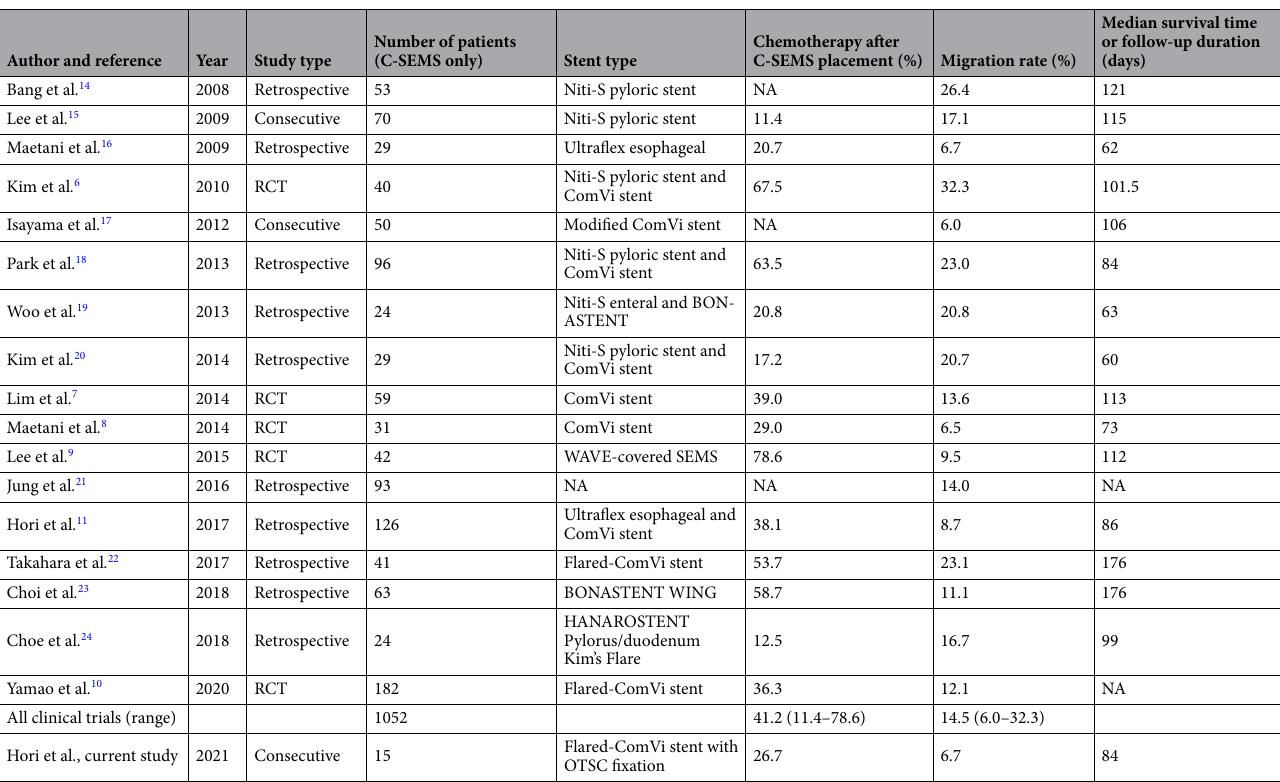
Table 3. Migration rate of published endoscopic gastroduodenal covered stenting. C-SEMS covered self- expandable metal stent, NA not available (or no details), OTSC over-the-scope-clip, RCT randomized controlled